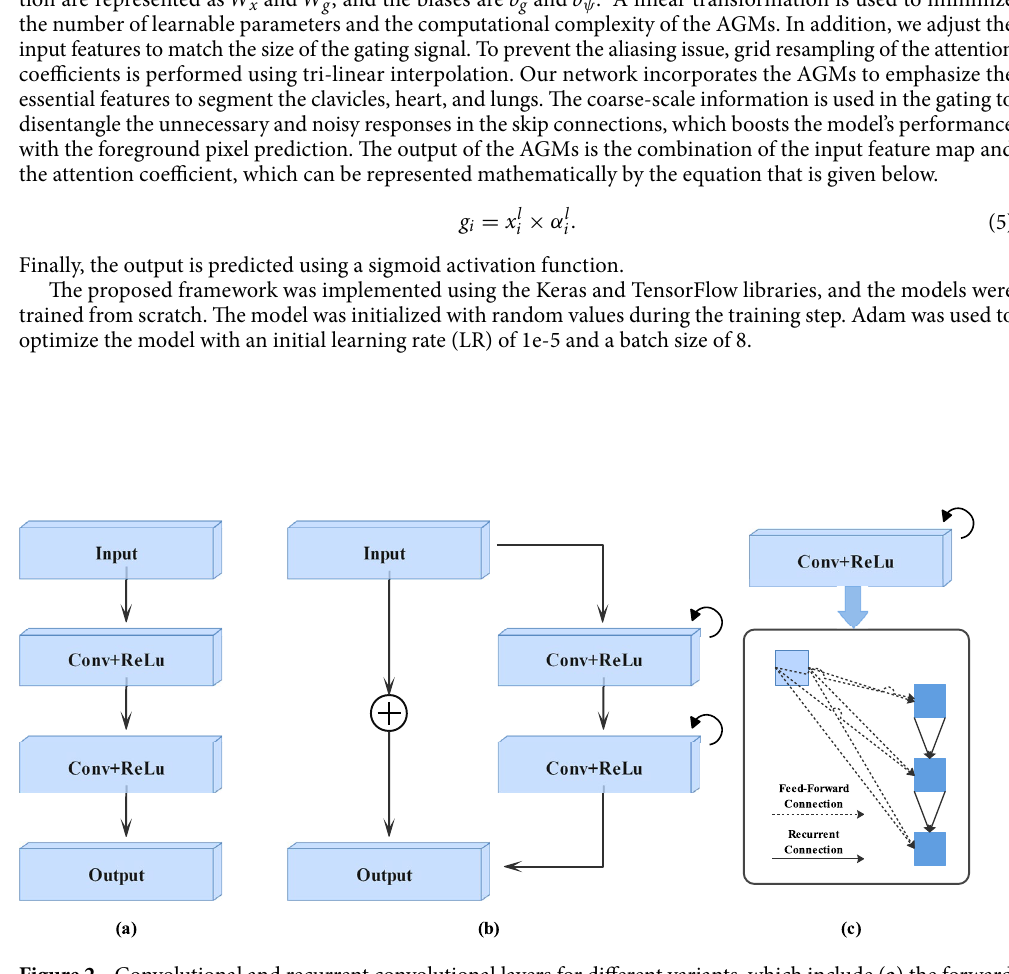
Figure 2. Convolutional and recurrent convolutional layers for different variants, which include ( a ) the forward convolutional layer, ( b ) the recurrent residual convolutional layer (R2CL), and ( c ) depicting the unfolded recurrent convolutional layer for T =